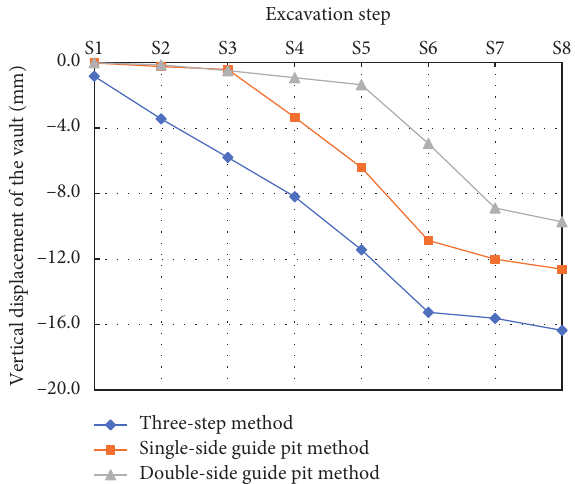
Figure 32: Displacement of the vault of tunnel